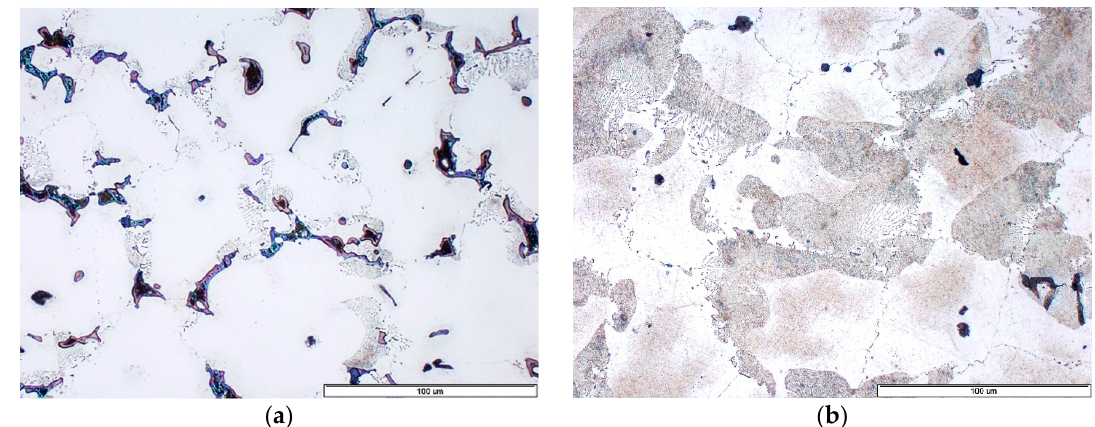
Figure 5. Microstructure of AZ91 alloy after modification with hexachloroethane: ( a ) as-cast, ( b ) heat-treated.